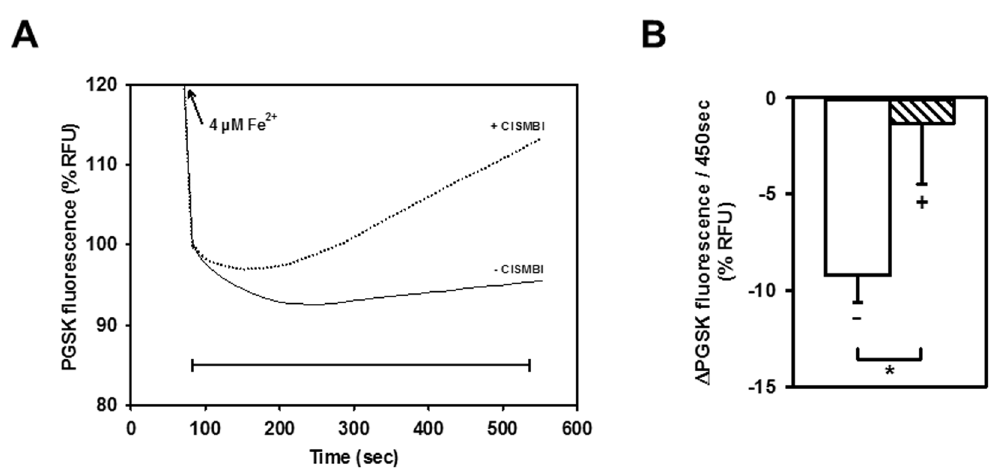
+ 2 of 1.3 µ M Fe 2 + . RFU, relative K ( ) Fe 0 5